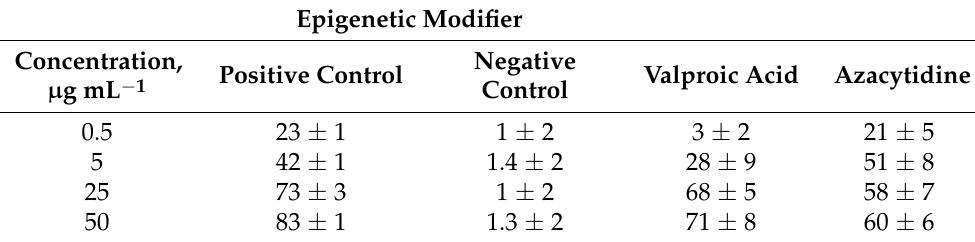
Table 1. Antioxidant potential assessed as DPPH radical scavenging activity (percentage of control with no epigenetic modifier addition, mean ± SD, n = 3) of the crude extract of P. heveicola cultured in medium with different concentrations of two epigenetic modifiers. In addition, included positive control roamarinic acid and negative control